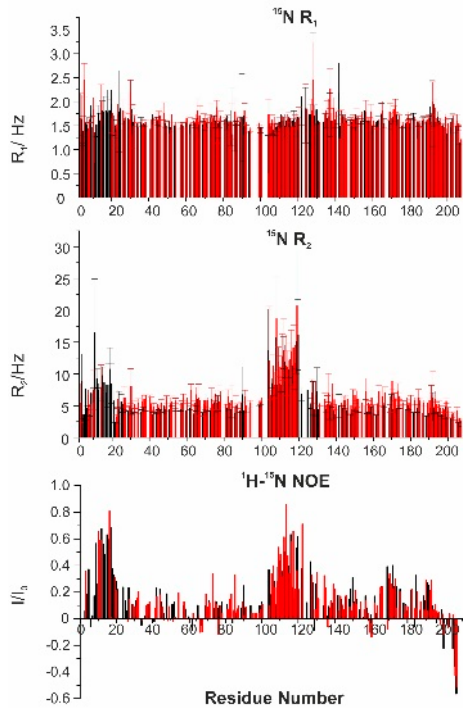
Figure 8. Nuclear relaxation data for backbone amide 15 N obtained for CBP-ID4 (black) and the 1:1 complex CBP-ID4:E1A12S (red). From the top to the bottom, 15 N longitudinal relaxation rates (R 1 , Hz), 15 N transverse relaxation rates (R 1 H- 15 N 2 , Hz) including proline residues, and